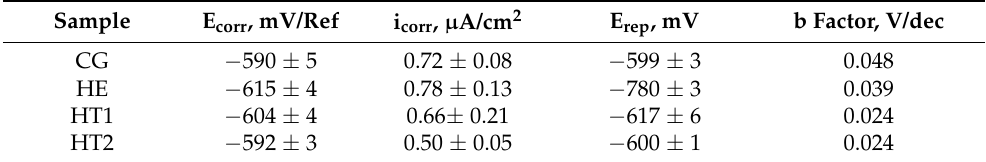
Figure 11. PP curves of the CG, HE, HT1, and HT2 AA 7075 samples following 600 s of E OCP stabilization in 0.05 M NaCl solution. Table 2. Average values of corrosion potential (E corr ), corrosion current density (i corr ), and repassivation potential (E rep ), b factor calculated from the potentiodynamic polarization